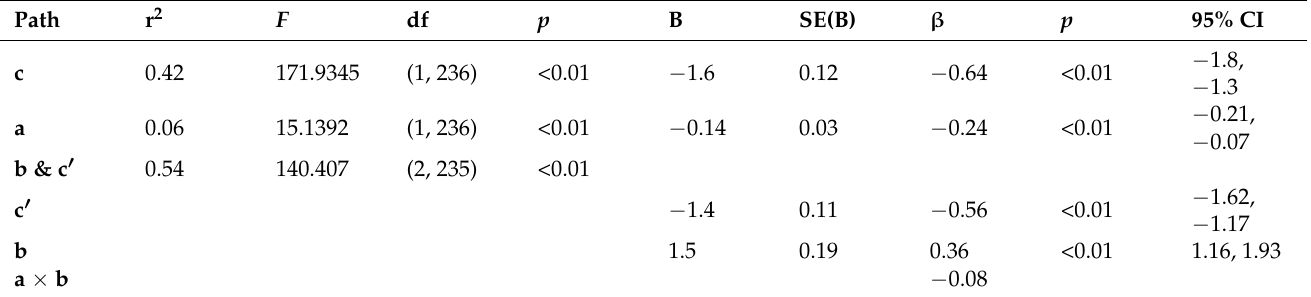
Table 3. A model of mediation for the investigated variables: personality, marital adjustment, and relationship